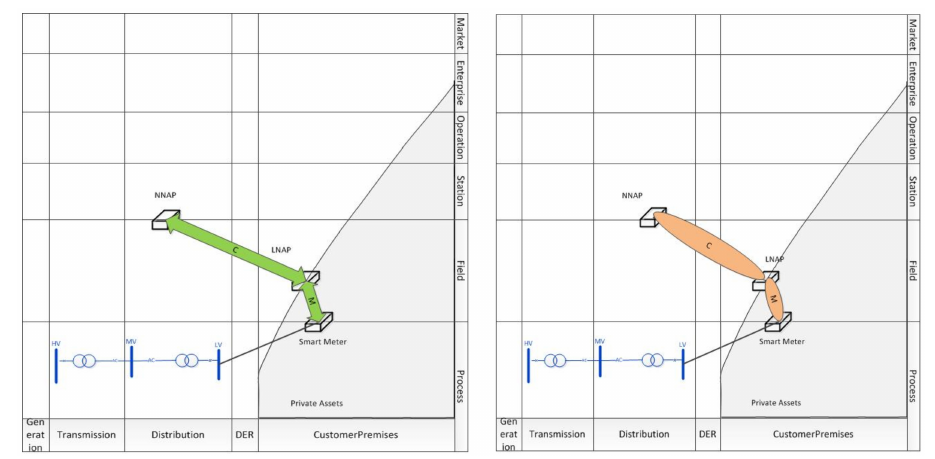
Figure 4. Use Case representation of the communication and information